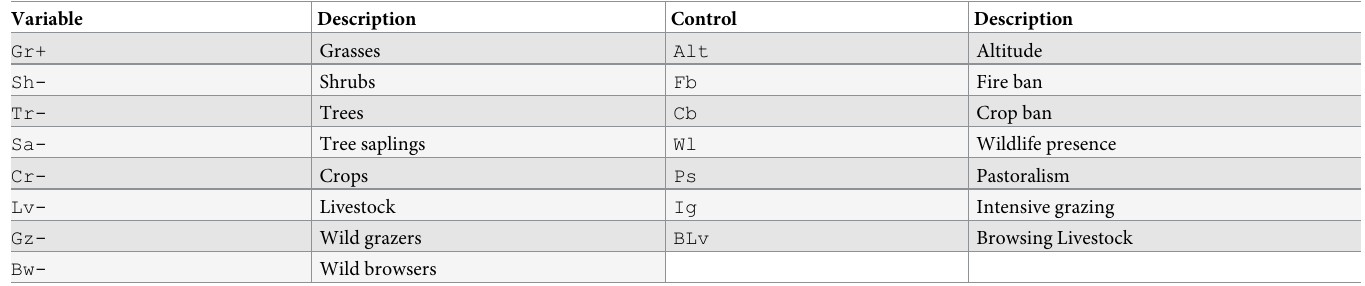
Table 1. Variables and controls of the Borana model . The initial values of the variables are noted next to their symbols.